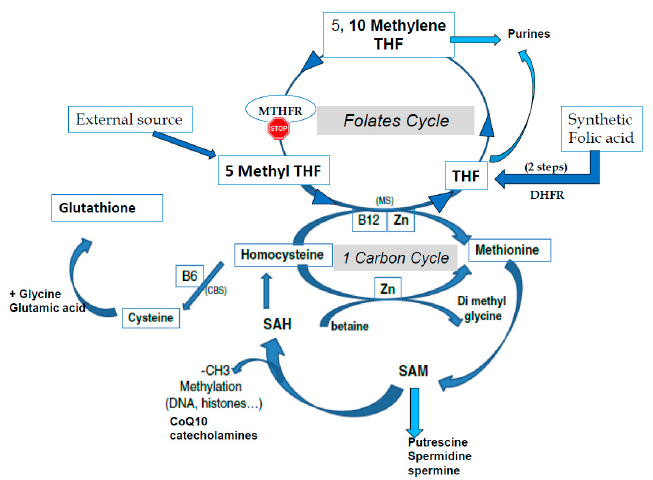
Figure 1. The one-carbon cycle (1-CC) and the folates cycle (MTHFR: methyltetrahydrofolate reductase, THF tetrahydrofolate). CBS: Cystathionine beta synthase, CoQ10: Coenzyme Q10, CH3: methyl group, DHFR: Dihydrofolate reductase, MS: methionine synthase, SAM S Adenosyl Methionine, SAH: S Adenosyl Homocysteine, Zn: Zinc.